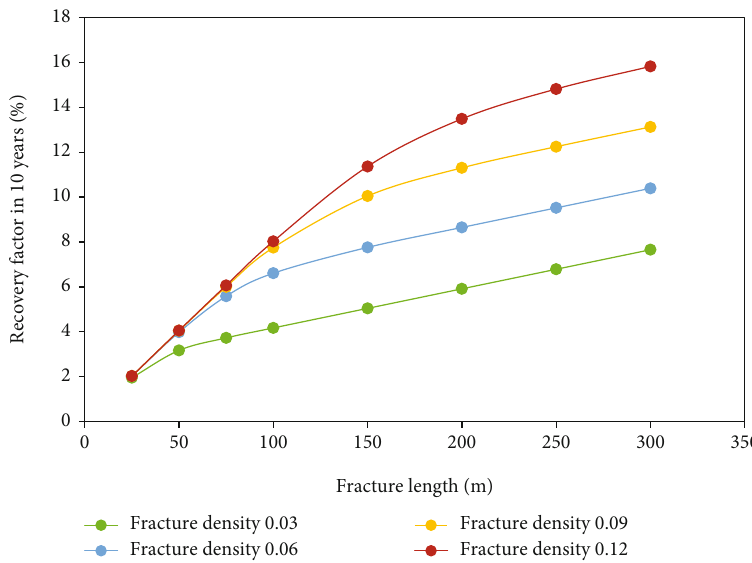
Figure 12: Relationship between the fracture length and the oil recovery factor.